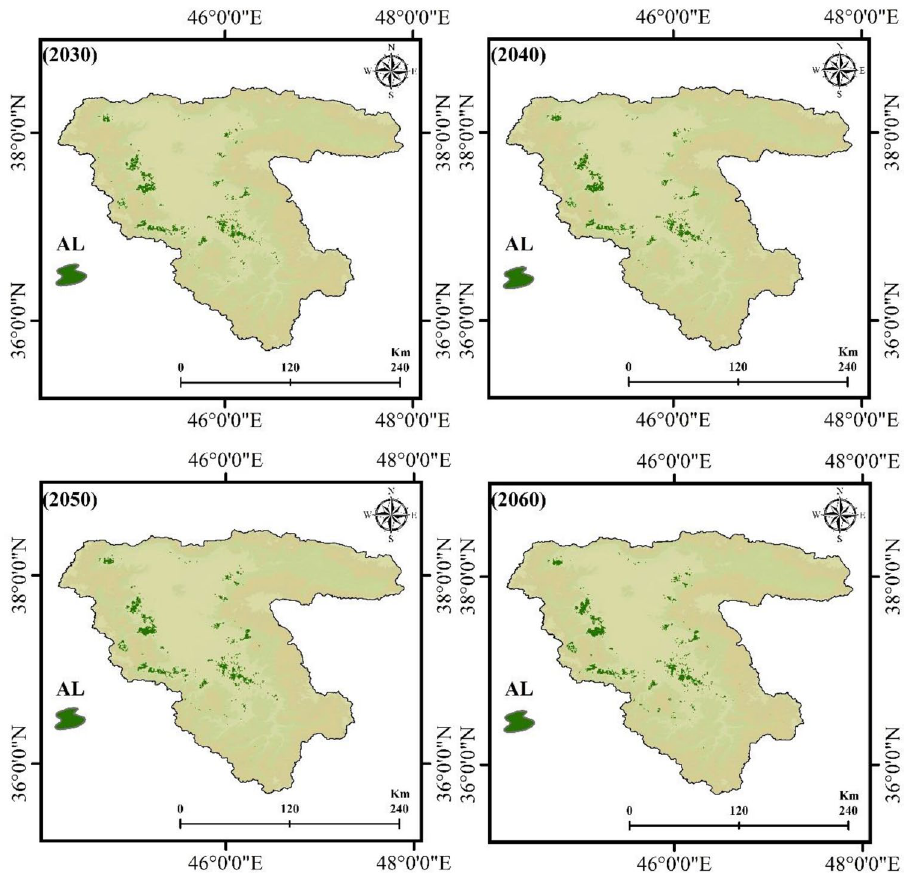
Figure 10. Results of the AL predication using the CA–Markov model for the years 2030, 2040, 2050, and 2060, generated in the ArcGIS 10.6 software (www. esri. com).